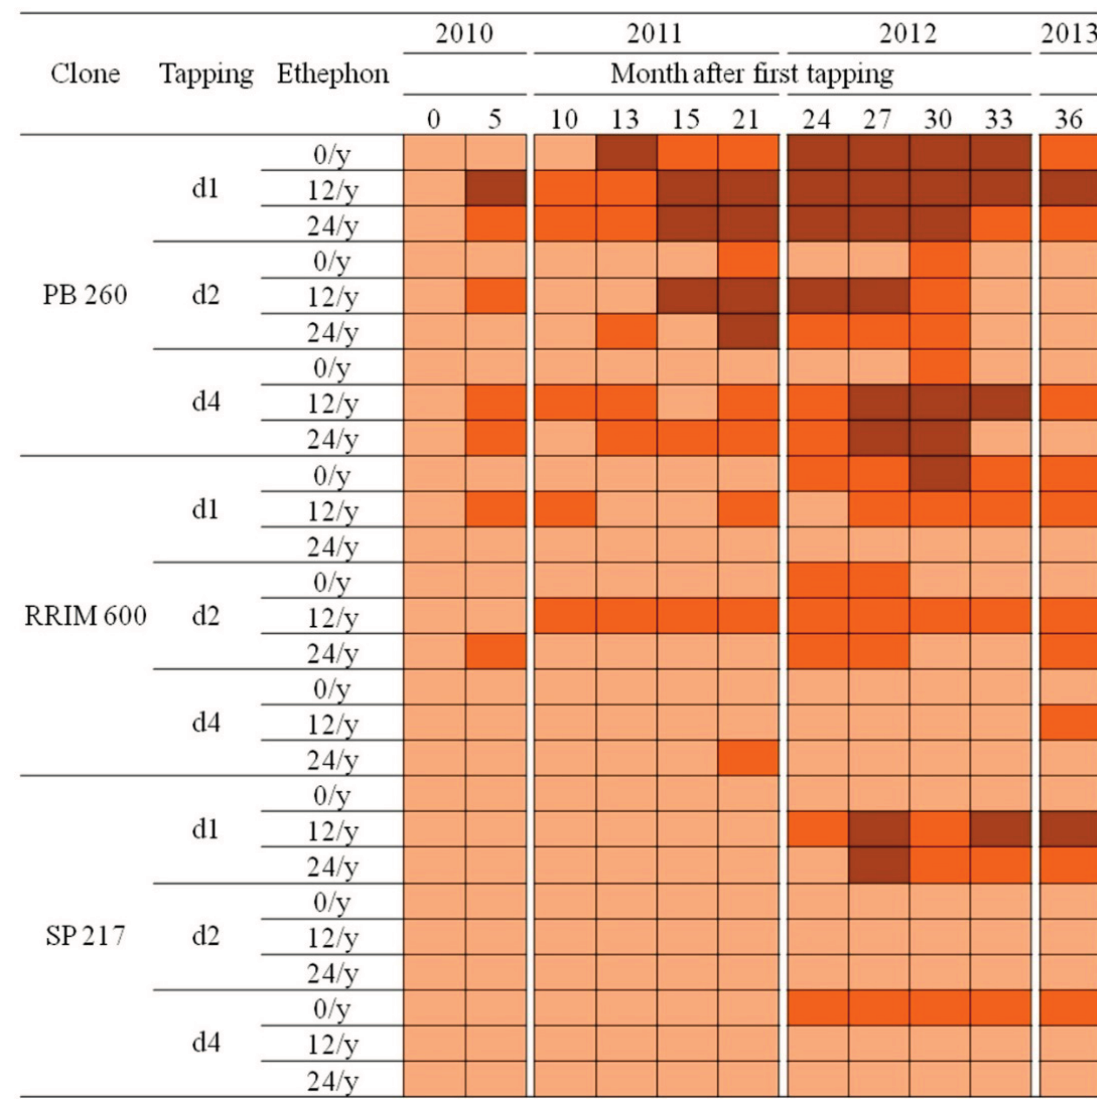
Figure 4. Dry cut length (DCL) measurements for three rubber clones (PB 260, RRIM 600, and SP 217) with contrasting latex metabolism during 36 months of observation. The data was presented by light brown, medium brown, and dark brown colours representing 0%–33%, 34%–66%, and 67%–100% of DCL,